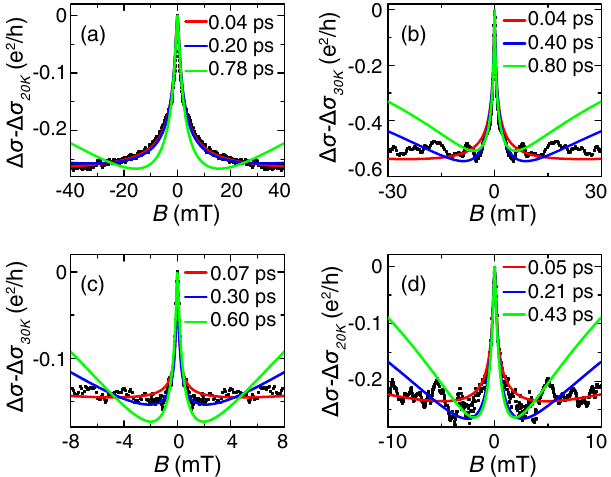
FIG. 5. Comparison of WAL data measured on monolayer graphene on different TMDs with the theoretical predictions of Eq. (1). In panels (a – d), the black dots represent the data; the solid lines of different colors represent the predictions of Eq. (1) for different values of spin-relaxation time τ . In panel (a), data from so a low-mobility device ( μ ¼ 3000 cm 2 = Vs) on WSe 2 are shown; panels (b – d) show data on higher mobility devices (respectively, 23 400, 33 000, and 110 000 cm 2 = Vs) on WS 2 (b), MoS 2 (c), and > 0 . 5 ps in WSe 2 (d). Note in all cases that inserting values of τ so Eq. (1) leads to the appearance of a positive magnetoconductivity due to weak localization at higher B , which is not seen in the experiments. This allows us to determine an upper bound for τ so for all the devices investigated. All data in this figure have been measured at T ¼ 250